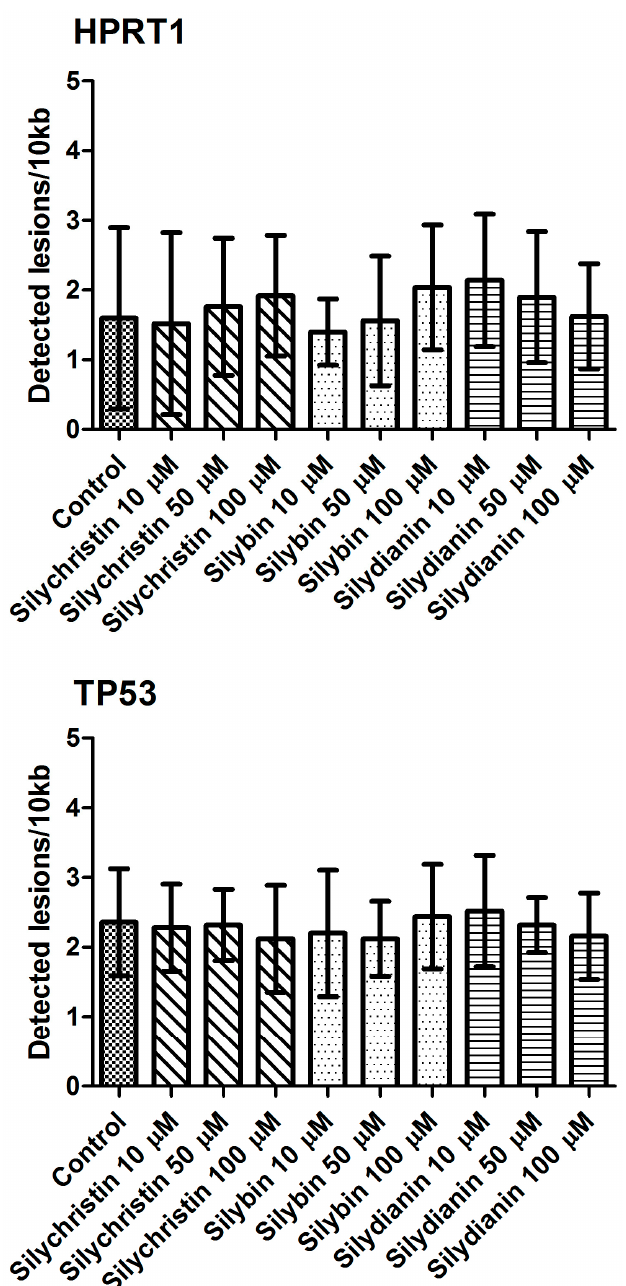
Figure 8. The effect of flavonolignans (silychristin, silybin and silydianin in concentrations of 10, 50 and 100 µM) on nuclear DNA (nDNA) lesion frequency per 10 kb DNA in HPRT1 and TP53 genes estimated by SLR-qRT-PCR amplification of total DNA from A549. The data represent means of ± SD, n = 8.